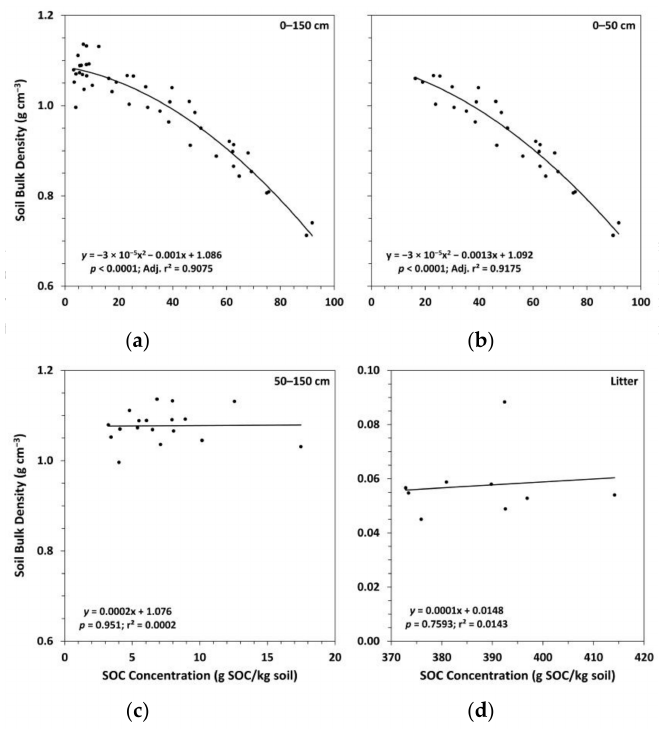
Figure 3. Soil bulk density versus soil organic carbon (SOC) concentration for: ( a ) the whole mineral soil ( n = 45); ( b ) the 0–50 cm soil depth layers ( n = 27); ( c ) the 50–150 cm soil depth layers ( n = 18); ( d ) the litter layer ( n =